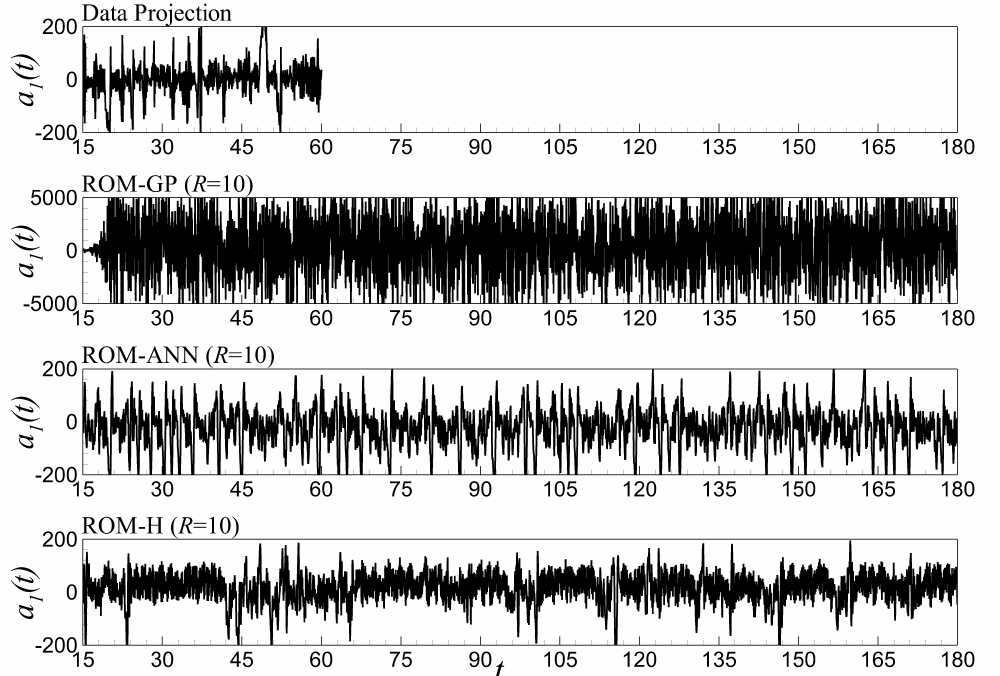
Figure 23. Forecasting of temporal mode evolution of a 1 ( t ) for Re = 400. Note that all ROMs are trained by the data snapshots obtained between t = 15 and t = 60. Although the ROM-GP approach provides reasonable (physical) results at the beginning (i.e., t < 18), the error is then amplified